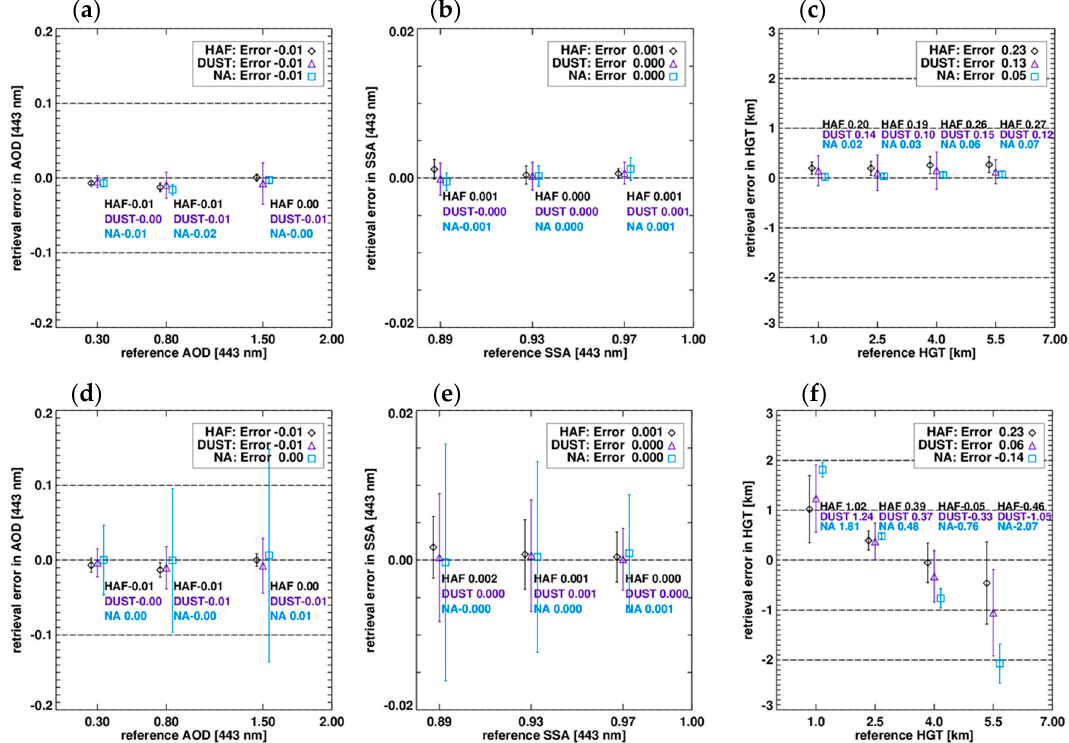
Figure 11. Inversion error of the OE method for ( a , d ) AOD, ( b , e ) SSA and ( c , f ) ALH retrieval, without errors in model parameters. The a priori ALH is based on actual conditions in the upper panels but an a priori ALH of 3 km is assumed in the lower panels. The retrieval errors are estimated from 108-member ensembles of AOD and SSA retrieval and 81-member ensembles for ALH retrieval for a given set of reference conditions. Symbols indicate the aerosol type (diamonds: HAF, triangles: dust, squares: NA) and error bars represent the standard deviation of the smoothing error for the reference test dimension.